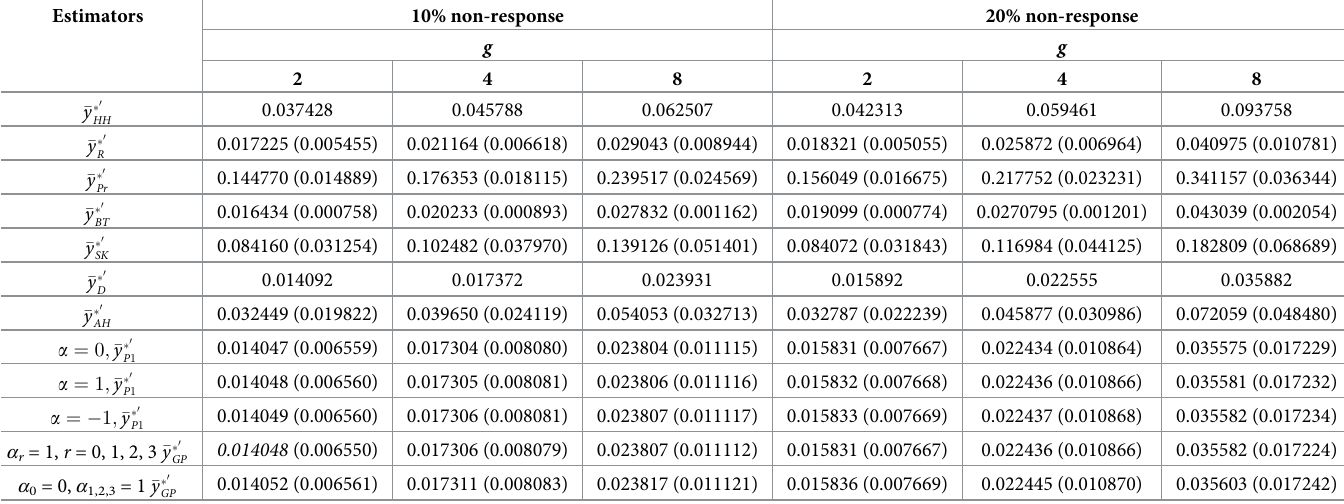
Table 6. Mean squared error and | Bias | (in brackets) values for different estimators for Population III with measurement error.